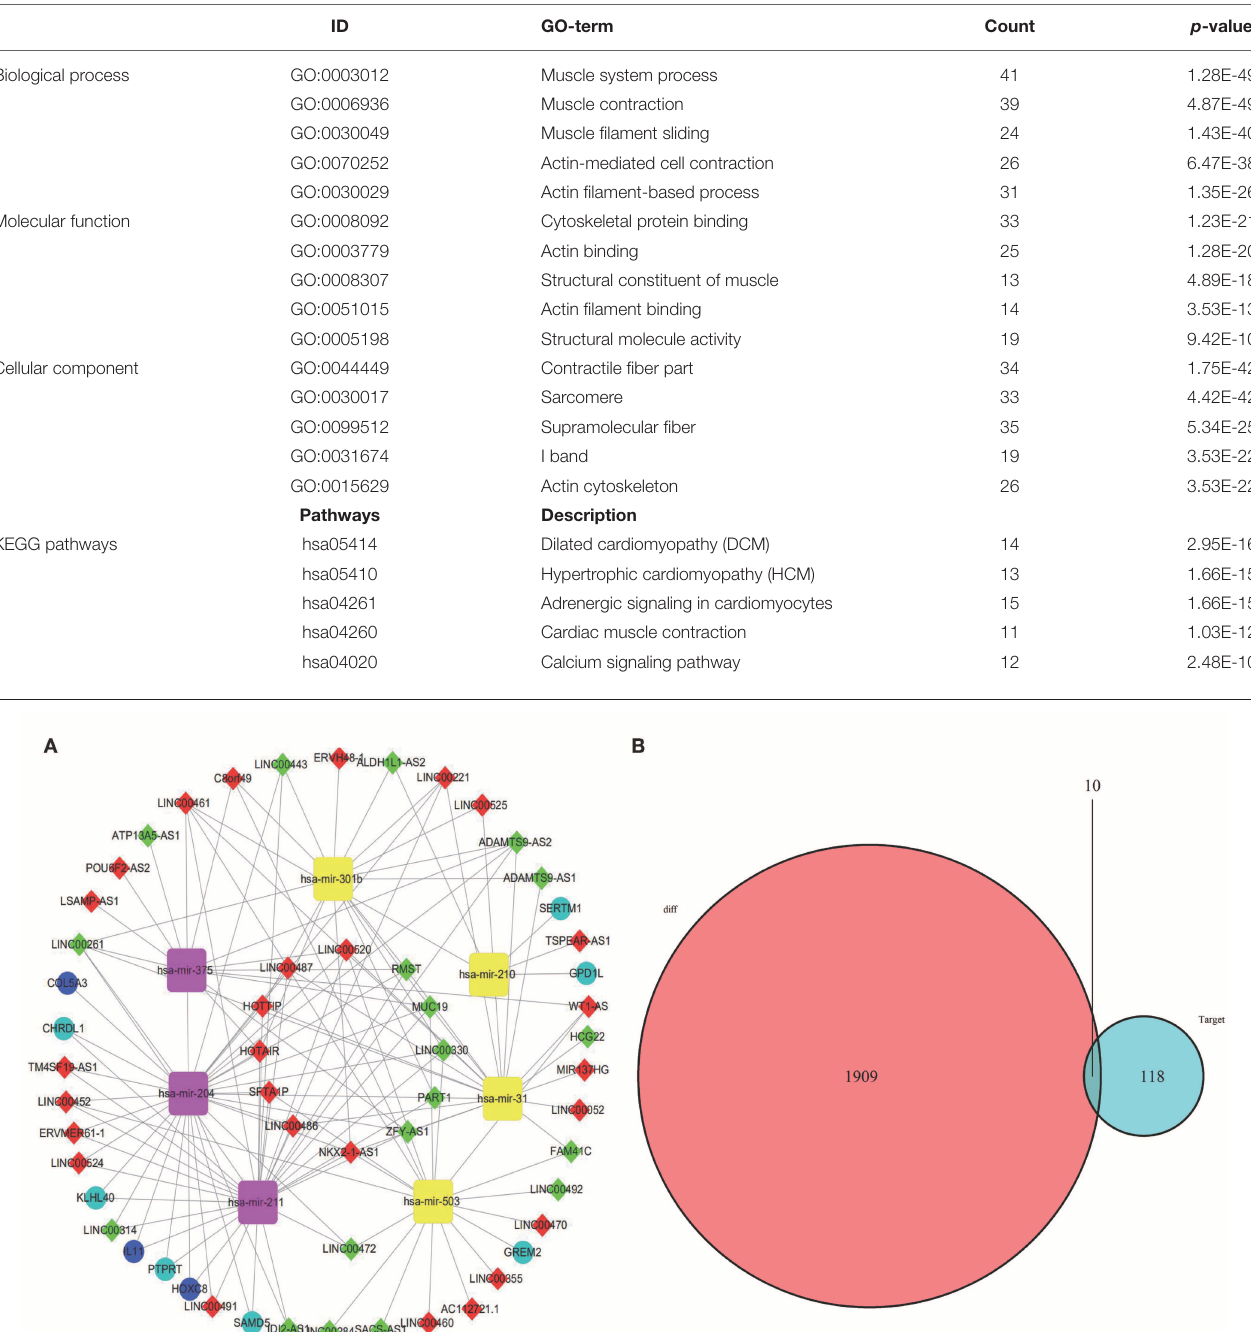
TABLE 3 | Module 3 GO and KEGG pathways analysis. ID GO-term Count p -value Biological process